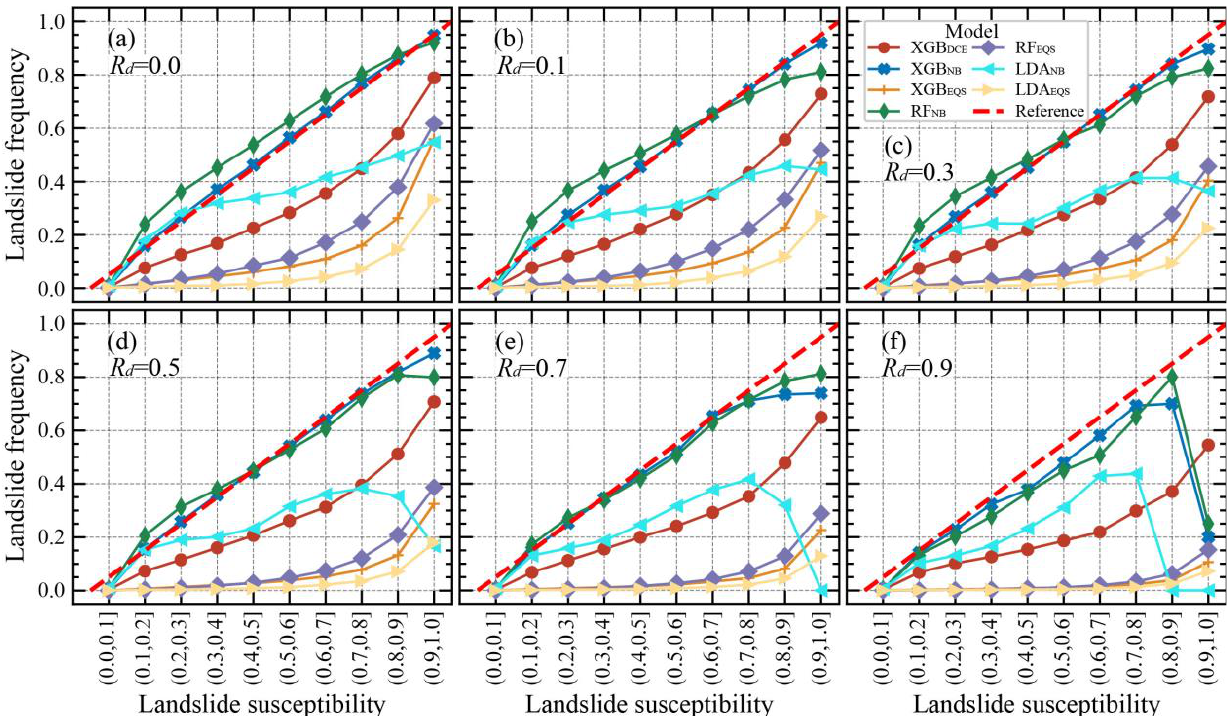
Figure 9. The relationship between the landslide frequency and the landslide susceptibility. The models with the plots closest to the reference lines have predicted susceptibility values that are close to the actual landslide frequency. ( a – f ), the R d increases, and the part of the landslide that the model seeks to predict is reduced from the entire landslide to the landslide scarp. Because some of the plots almost overlap (XGB-based model versus LGB-based model and EQS-based model versus ILW-based model), for clarity we show only representative model plots.